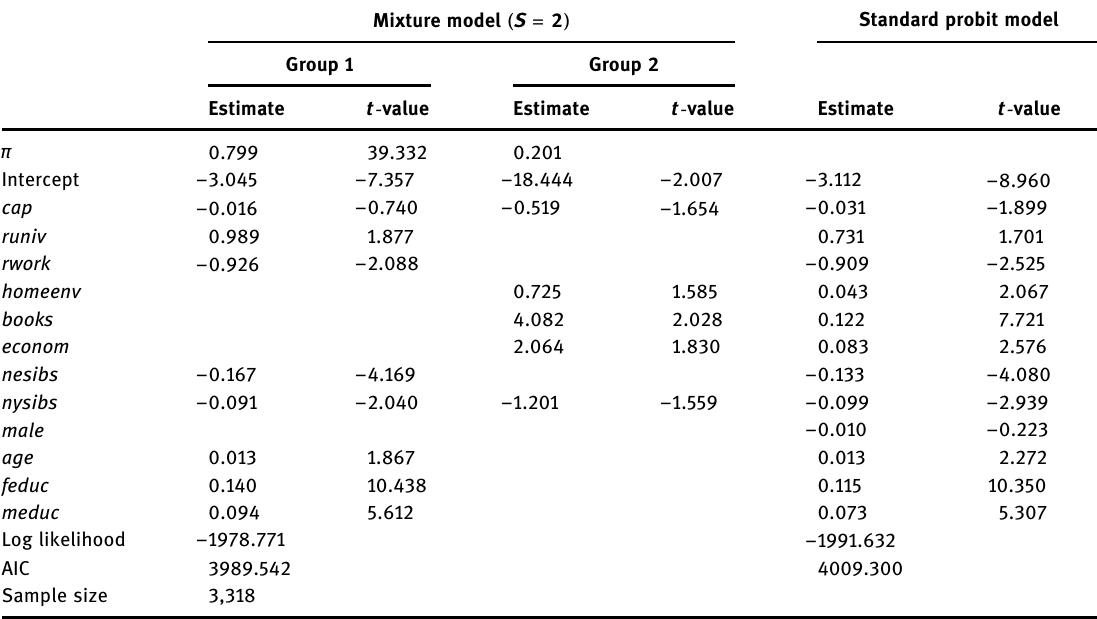
Table 3: Estimation results: treatment choice